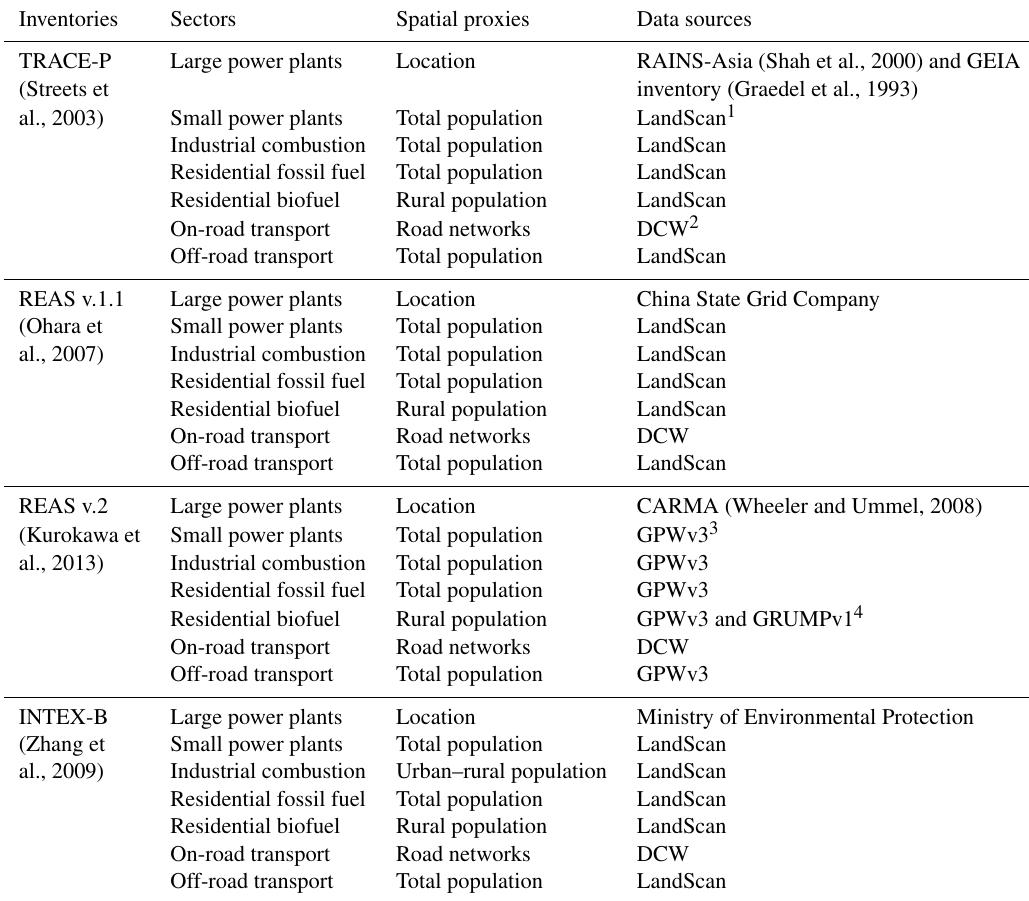
Table 1. Review of the spatial proxies used in regional bottom-up NO x emission inventories covering China.